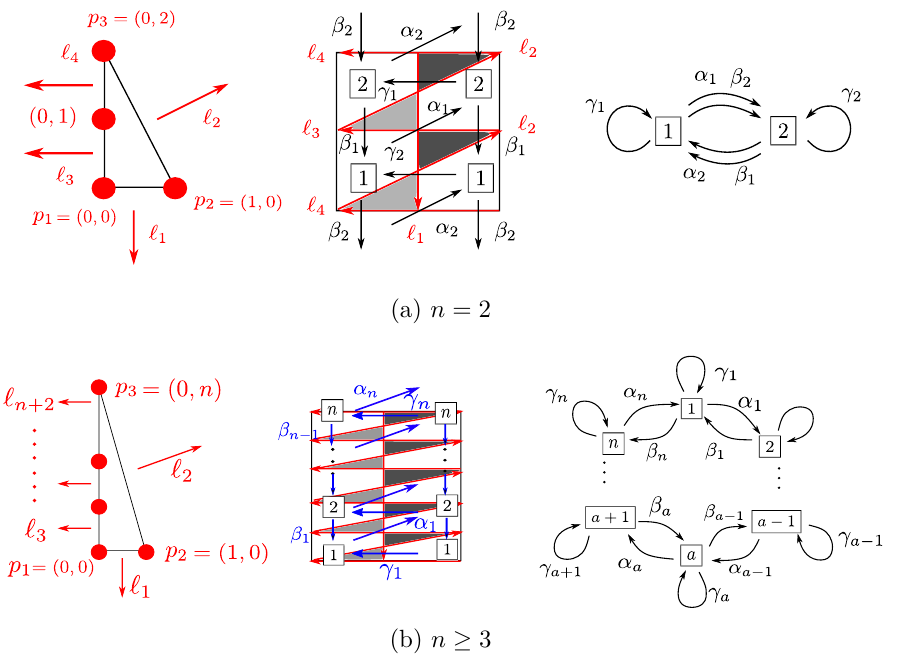
Figure 27. Toric diagram, periodic quiver diagram and quiver diagram of ( C 2 / Z n ) × C ( n ≥ 2) . The quiver structure depends on the value n . (a) When n = 2 , there are four arrows between the two vertices. (b) When n ≥ 3 , there are only two arrows between the adjacent